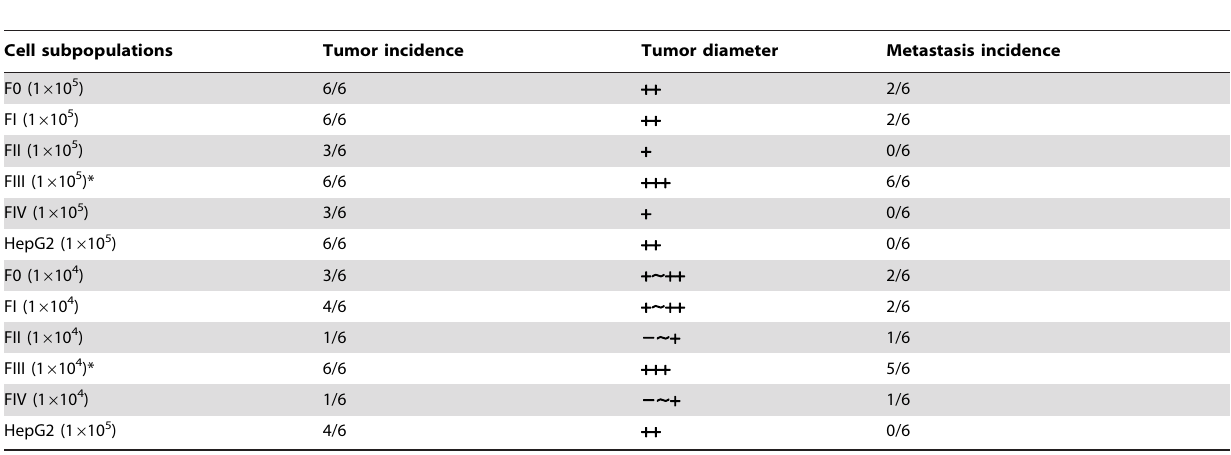
Table 3. The tumorigenic potential of cells from each fraction.